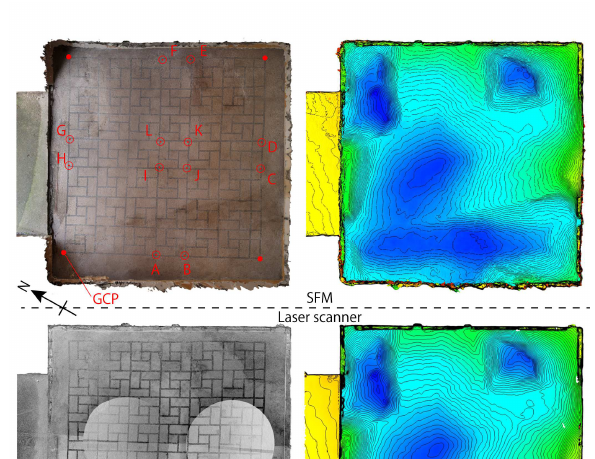
Fig.8 House of Jove & Ganymede room6